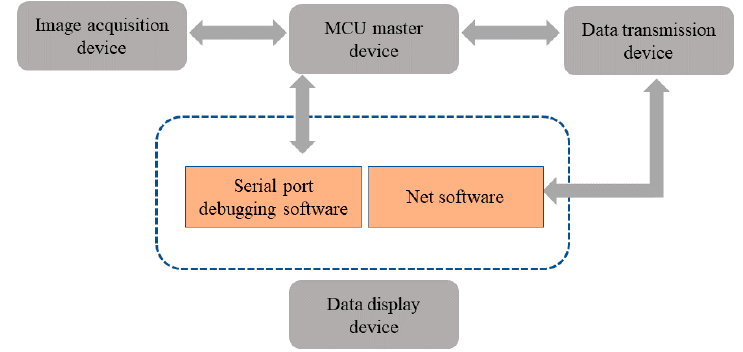
Figure 6. Block diagram of the overall system architecture.